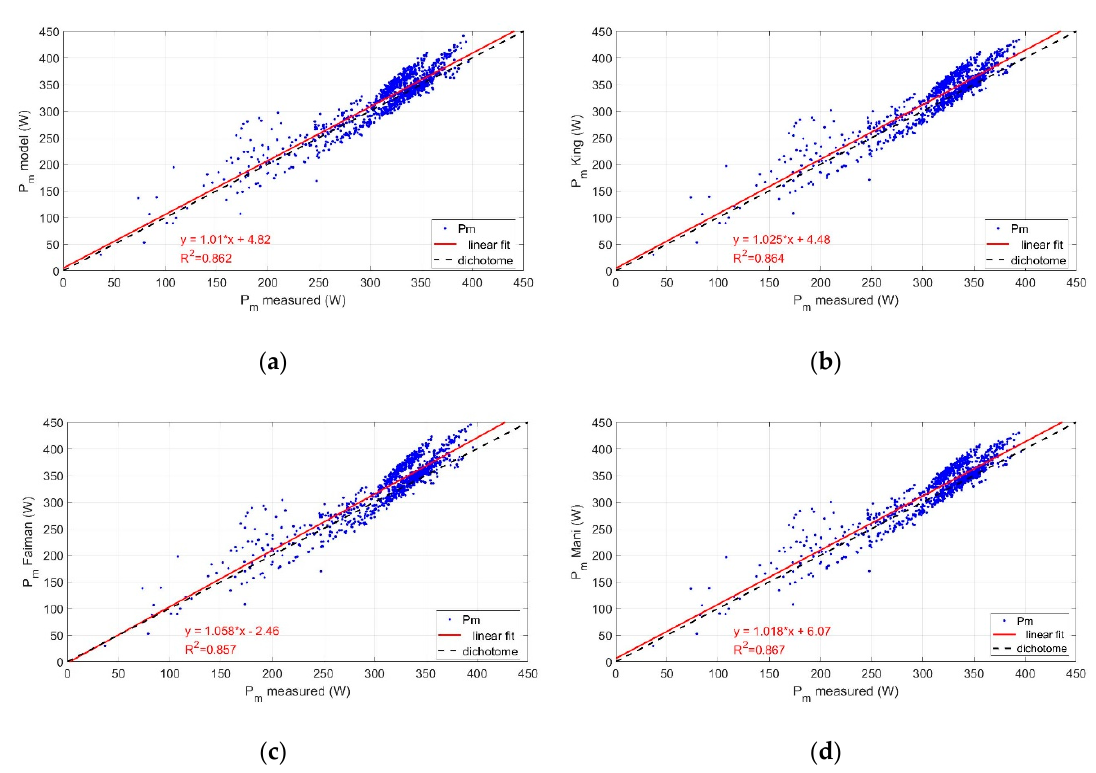
Figure 15. Pm predicted vs. measured for the sun-tracking PV system, by the ( a ) proposed model, ( b ) King’s model, ( c ) Faiman’s model, ( d ) Mani’s model.